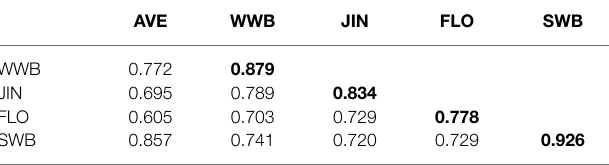
TABLE 6 | The discriminant validity of the measurement model. AVE WWB JIN FLO SWB